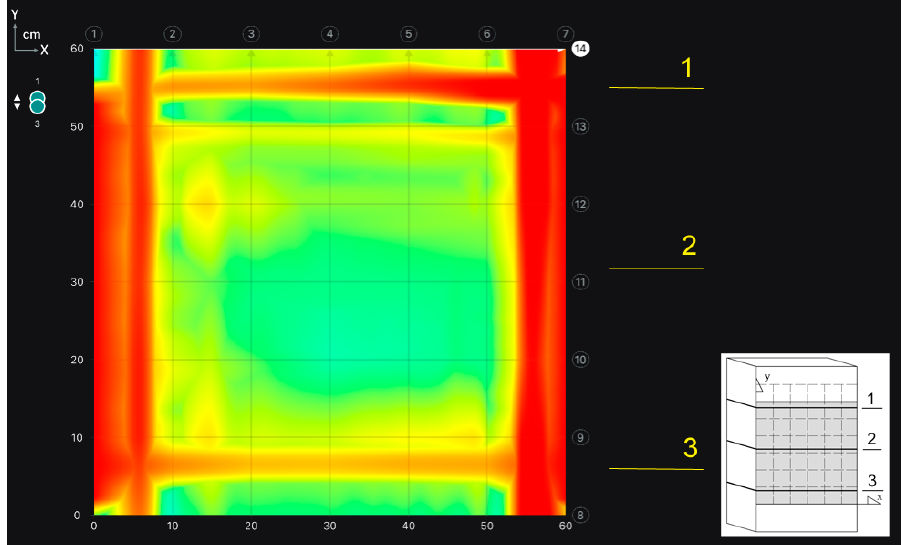
Figure 10. C-scan of the masonry specimen No. 2 at the depth of 10 ÷ 30 mm obtained from the GPR scanner (a surface scan).